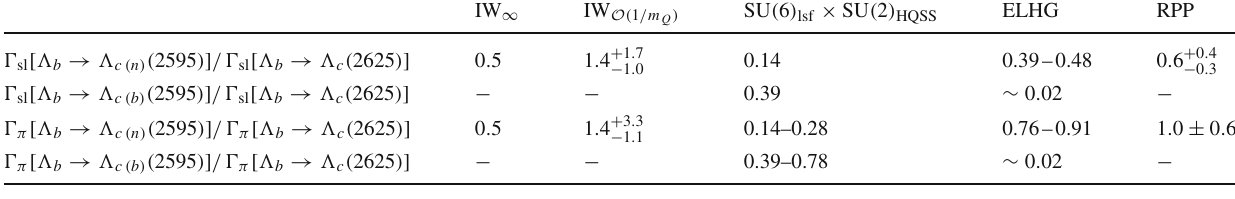
Table 3 Values (MeV) of the ( ∗ ) N G D ( ∗ ) N from factors g D R J Ref. [66] (SU ( 6 ) lsf × SU ( 2 ) HQSS ) and [73]